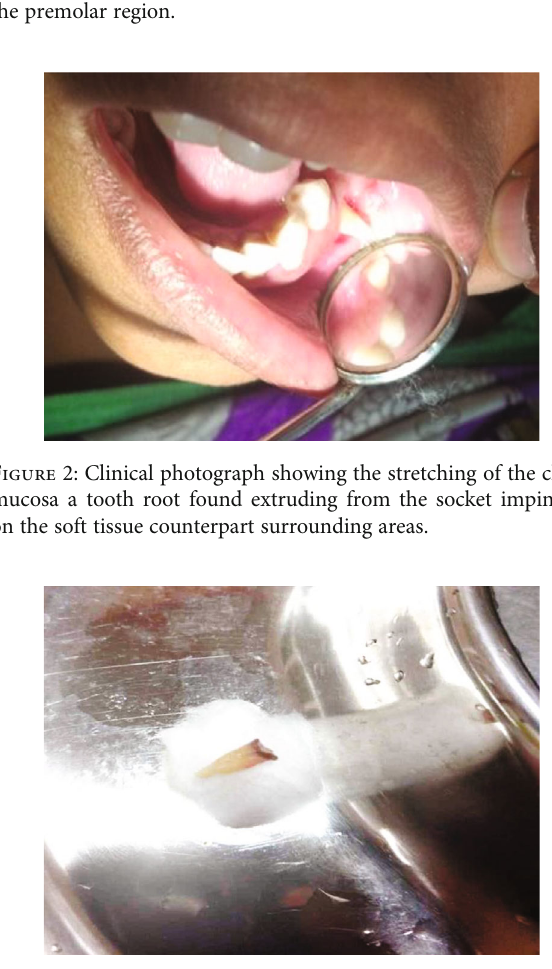
Figure 3: Clinical photograph showing a completely removed tooth under local